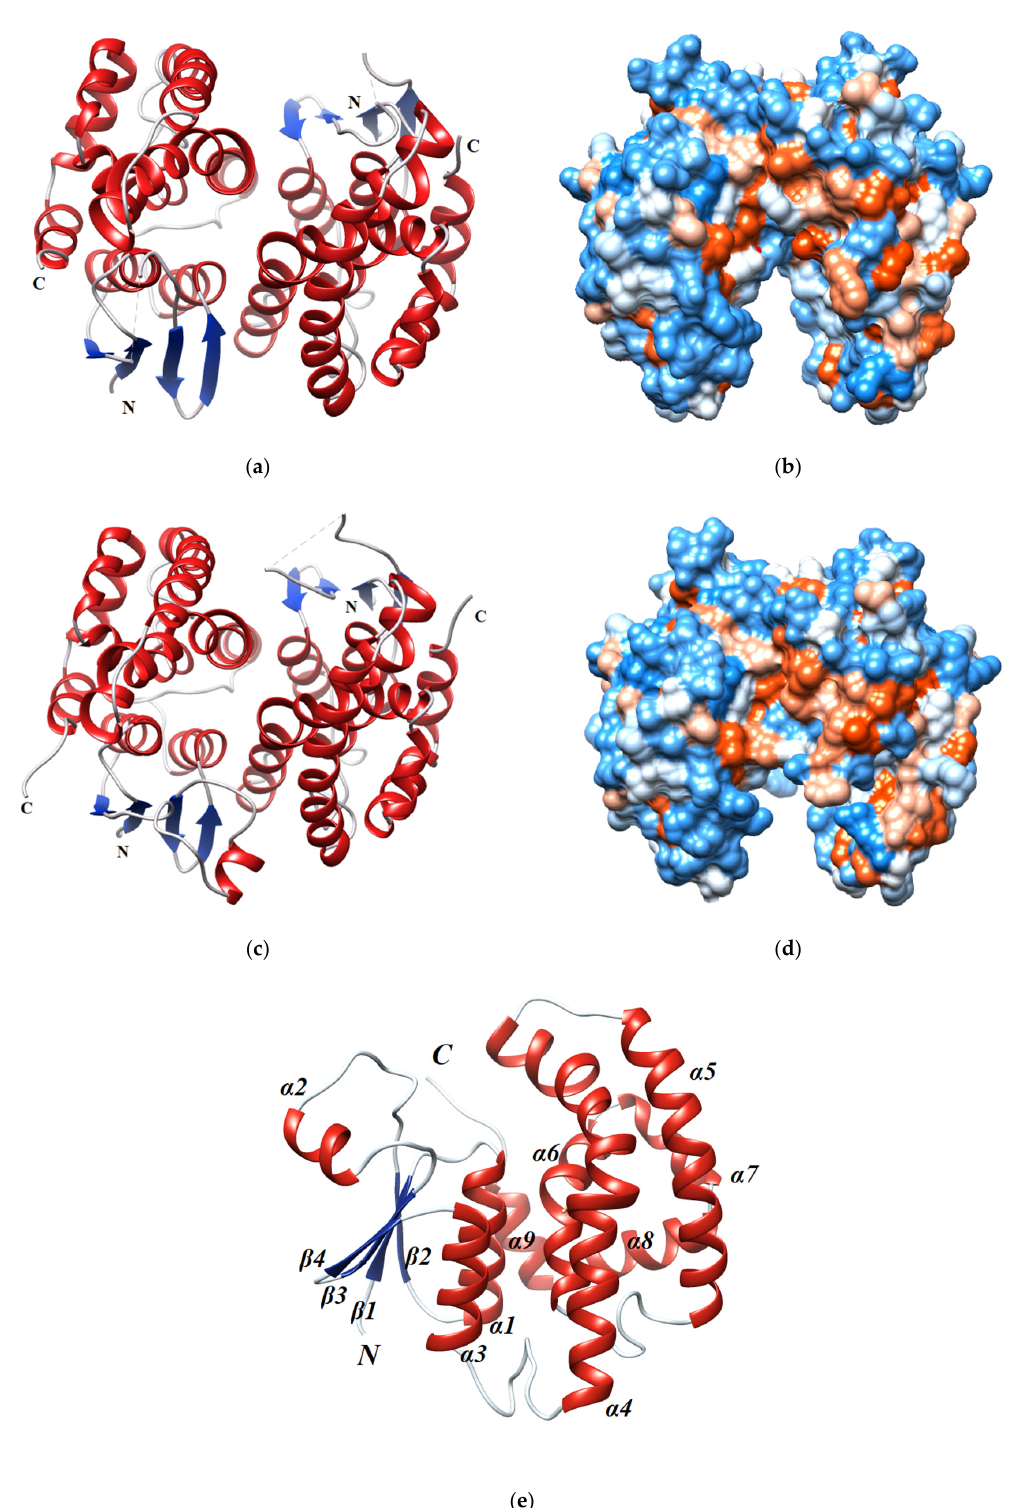
Figure 7. Crystal structure of the sh101 and sh155 enzyme variants. ( a , c ) Ribbon representation of the dimer protein (sh101 and sh155, respectively). The α -helixes (red) and β -strands (blue) are depicted. ( b , d ) Surface hydrophobicity of the homodimer protein. Hydrophilic areas are shaded in a blue color range and hydrophobic areas in an orange-red color range. The figures were created by UCSF Chimera [55]. ( e ) Ribbon representation of the monomer of sh155 variant. The α -helixes (red) and β -strands (blue) are